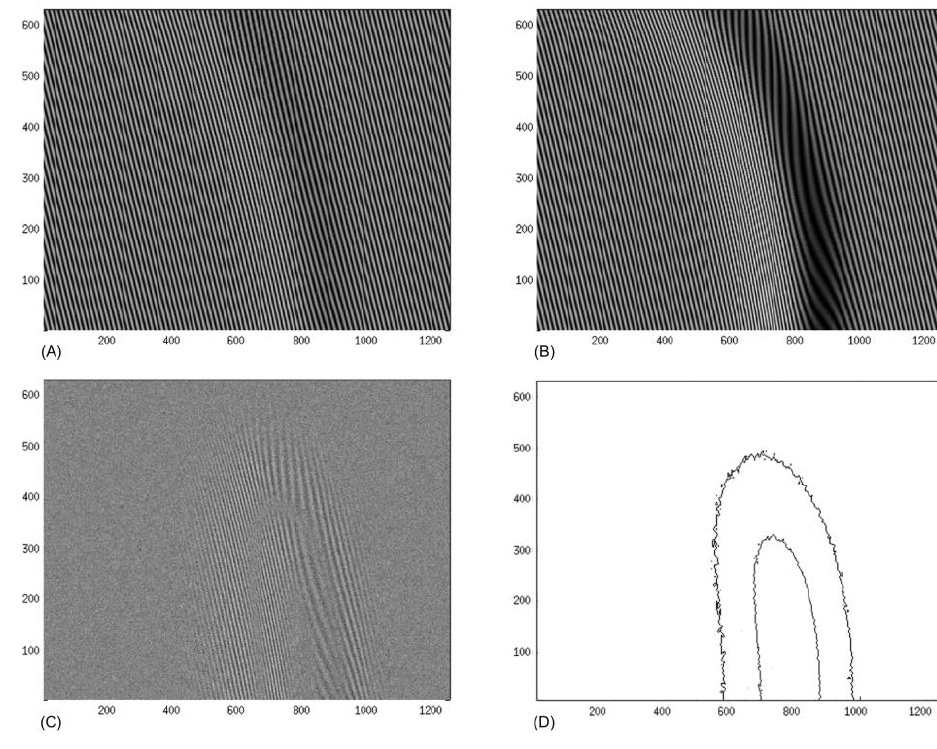
Figure 10. ( A ), ( B ) projected grating on a surface G(x) and deformed surface, respectively; ( C ) subtractive superposition of ( A ) and ( B ); (D) contour lines of the